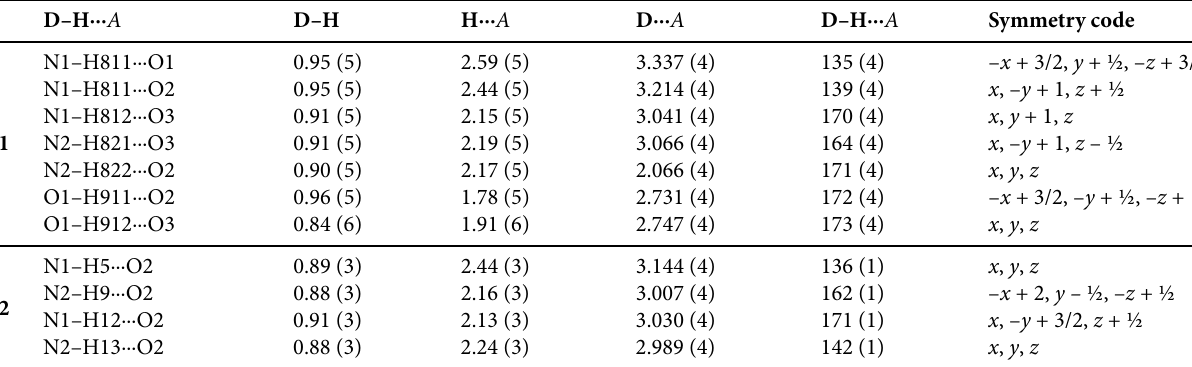
Table 3. Hydrogen bonding (Å) and angles (°) in complexes 1 and